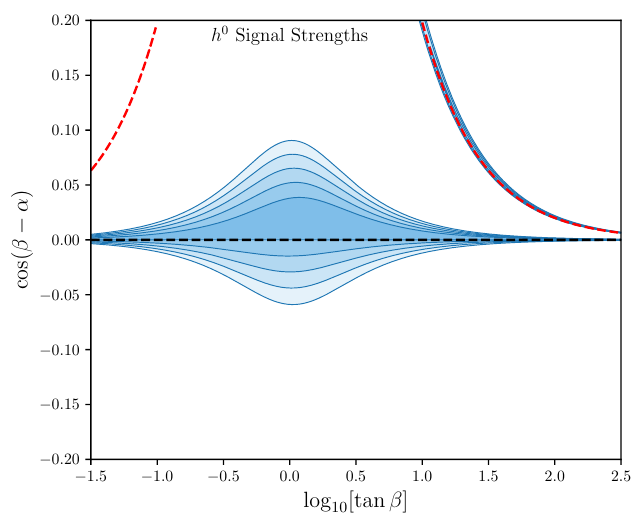
Figure 2. Contour plot of the allowed 2HDM-II parameter space in the (tan β − cos( β − α )) plane from the Higgs signal strengths, with the dashed black line indicating the alignment limit ( cos( β − α ) = 0 ) and the dashed red line the wrong sign limit of eq. (5.3). The contours indicate the allowed space at 1, 2, 3, 4, 5 σ from dark to